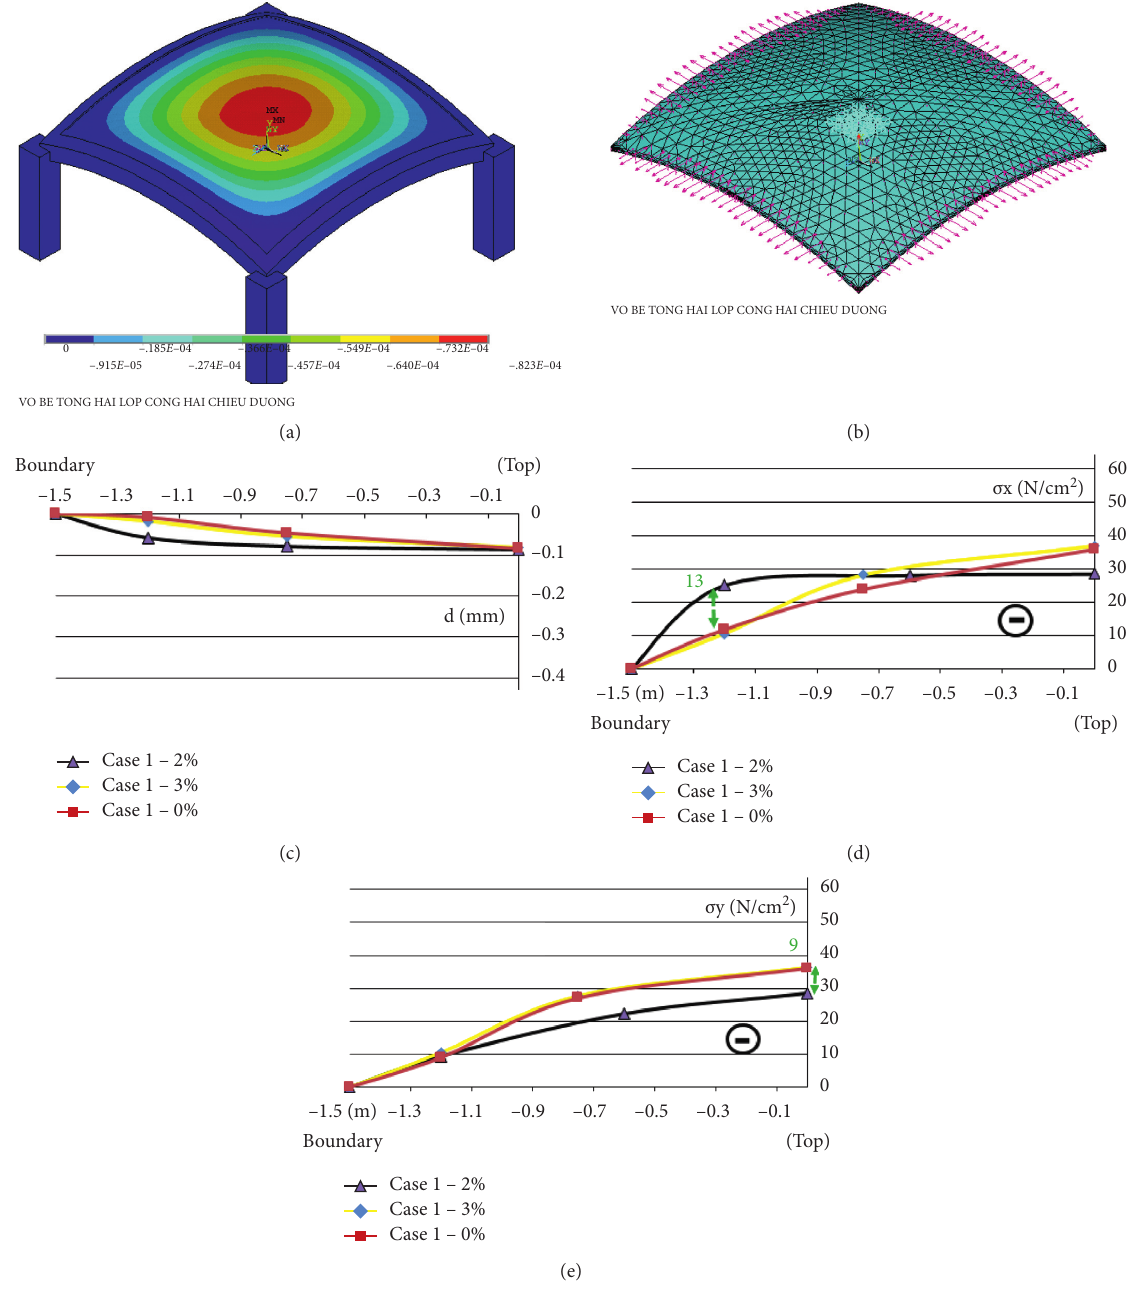
Figure 16: The change of percentage of steel fibres in concrete (Case 1). (a) Spectrum of vertical displacement in the shell; (b) the direction of movement of each layer; (c) vertical displacement of the shell; (d) stress σ x of shell; (e) stress σ y of Figure 19.